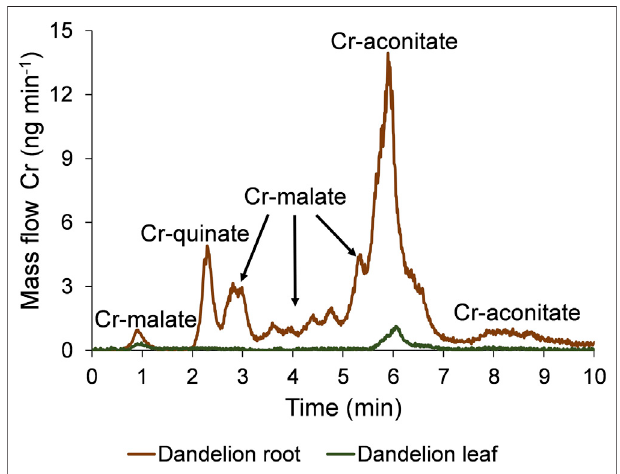
FIGURE 3 | Speciation of Cr in fi ve-times diluted dandelion root and leaf sap by HPLC-ICP-MS. Cr mass fl ow is based on measurements of isotope ratios m/ z 50 and 52. Dandelions were grown in soil from Vranja Pe č with a high Cr content (581 ± 11 mg kg − 1